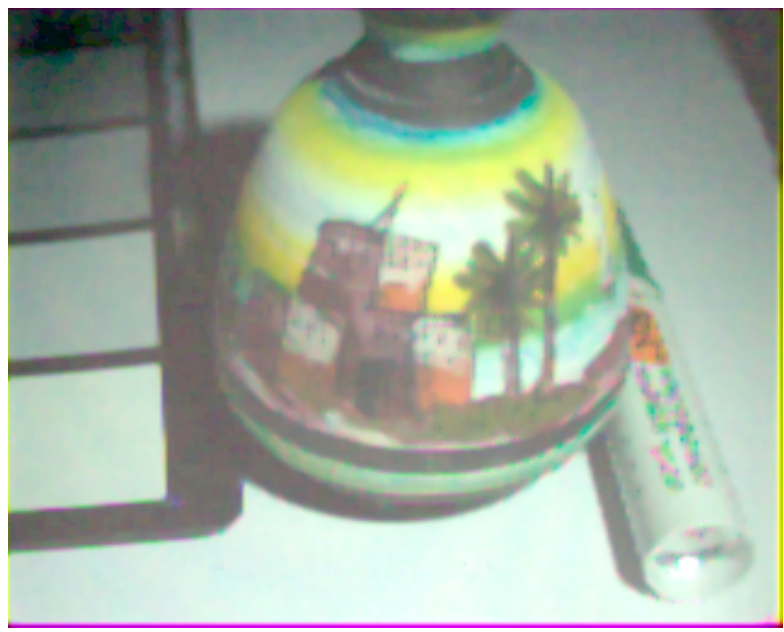
Figure 14. sRGB image of scene 2 computed according to a colorimetric calibration of the sensor. Color image is provided as Supplementary Materials in Figure